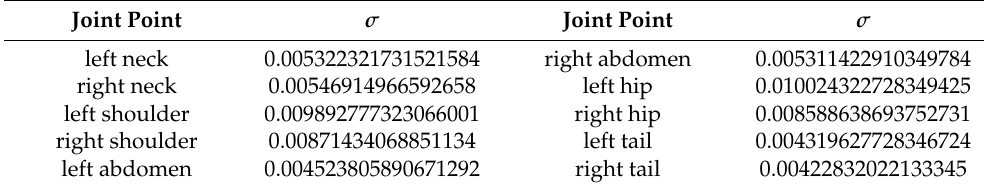
Figure 2. Pig joint point annotation example. (Black marks indicate left and right neck, blue marks indicate left and right shoulders, green marks indicate left and right abdomen, red marks indicate left and right hips, and orange marks indicate left and right tails). Table 2. Standard deviation of each joint